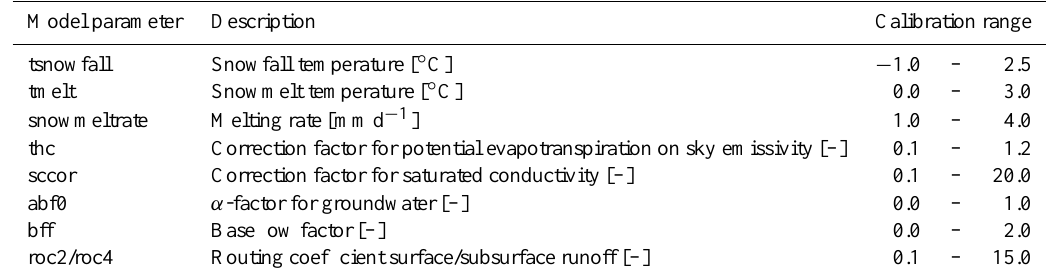
Table 1. Model parameters and their calibration